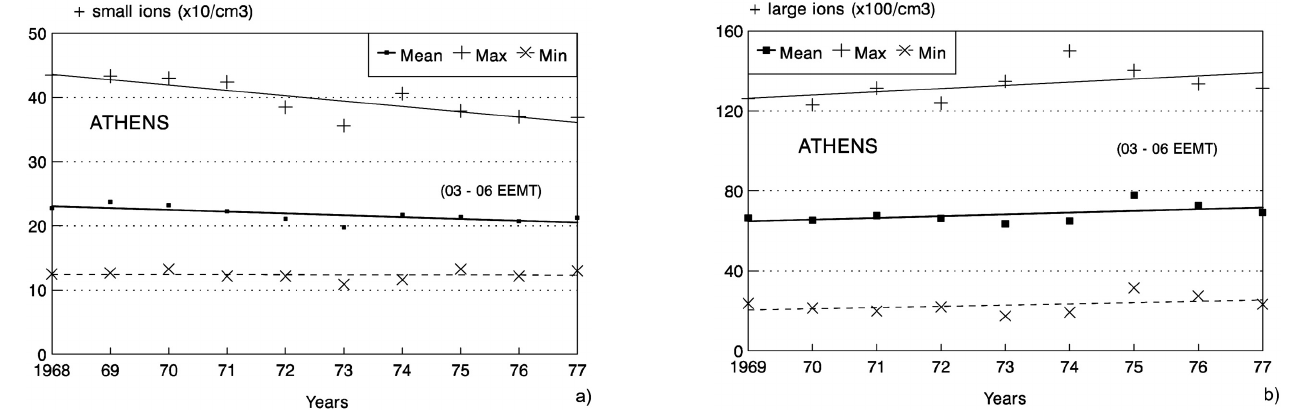
Fig. 3. (a) Changes in dawn values of the number of positive small ions (based on data from 03:00 to 06:00 EEMT) derived for Athens between 1968 and 1977. (b) The same as in the case of small ions (a), but for positive large ions from 1969 to